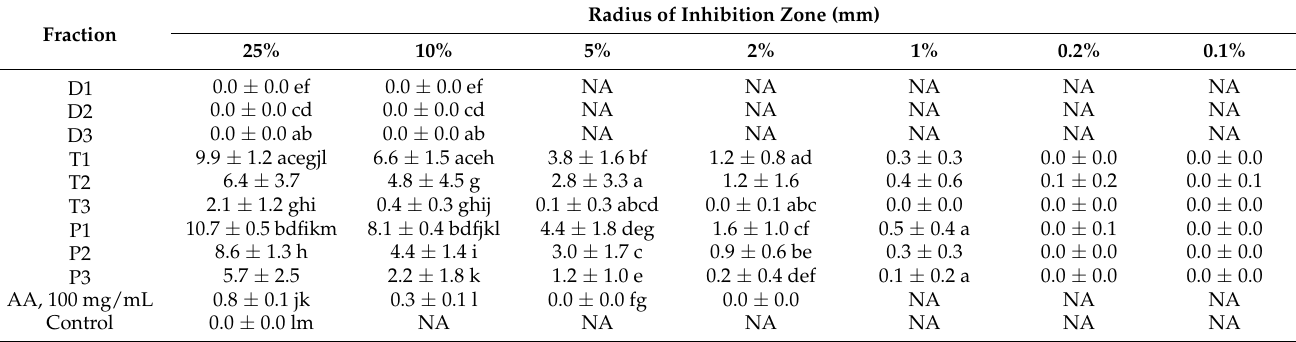
Table 4. Inhibition zones of the pyrolysis fractions against Candida albicans